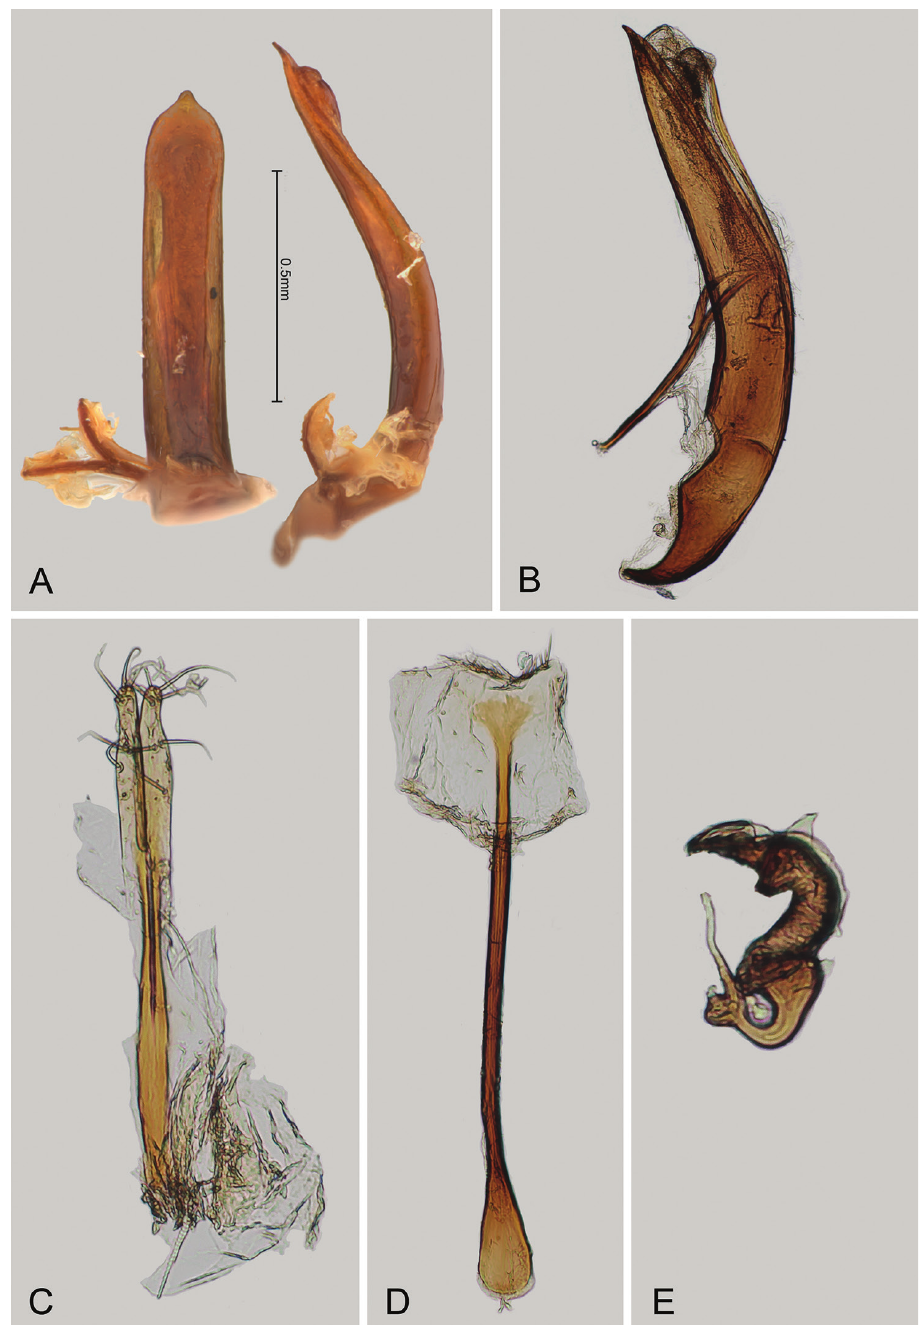
Figure 33. Andersonoplatus sanare . A Median lobe of aedeagus, ventral and lateral views B Median lobe of aedeagus, internal structures under compound microscope C Vaginal palpi D Tignum E